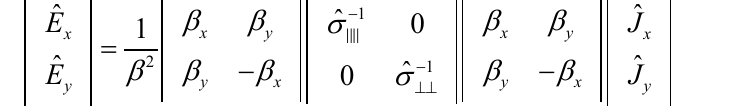
and ),( β  , normalized to σ  ||||